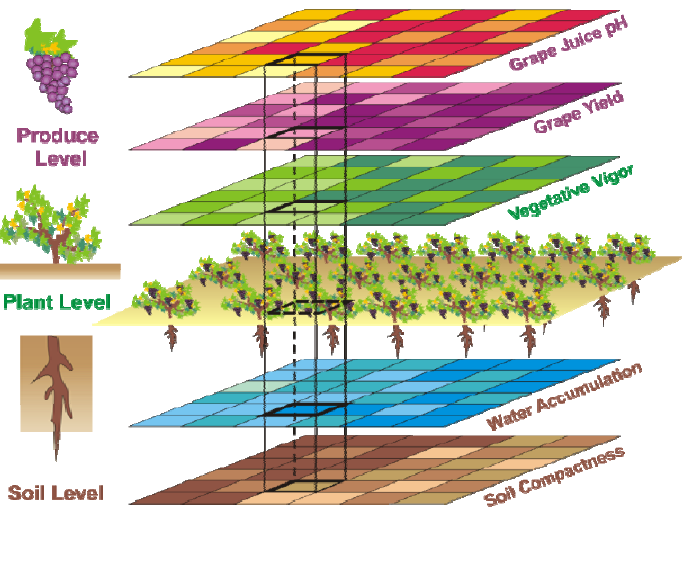
Figure 1. Tri-level division of traits for vineyard